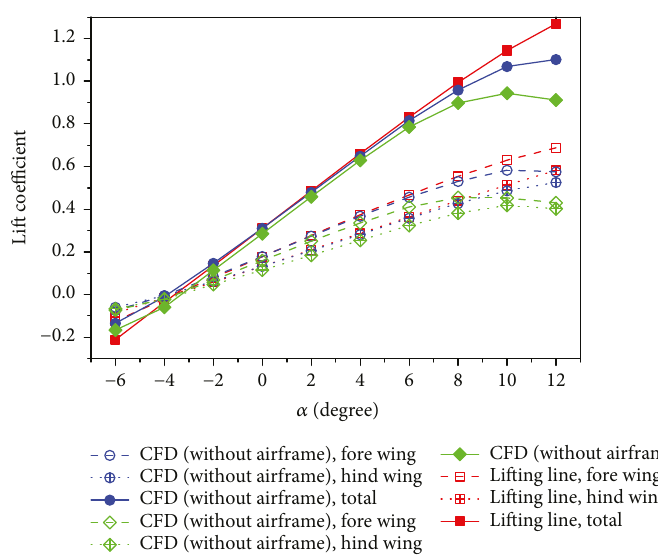
CFD (without airframe), fore wing CFD (without airframe), hind wing CFD (without airframe), total Figure 13: Lift curve comparison for tandem wing con fi guration with